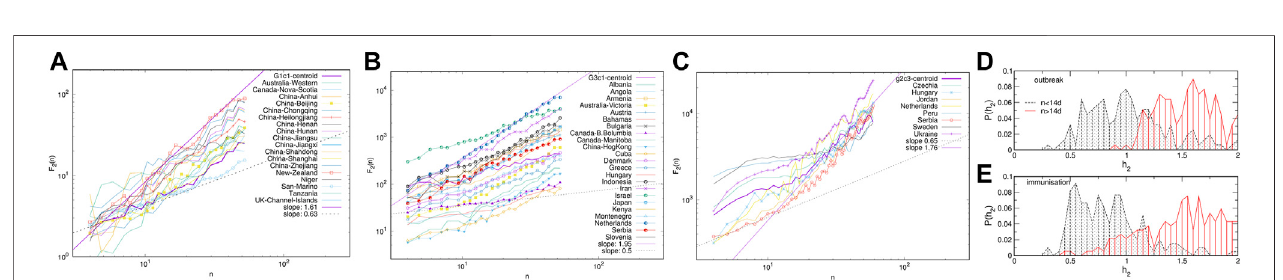
FIGURE 6 | Examples of the standard deviation F 2 ( n ) of time series vs . the interval length n for K-means clusters G1c1 and G3c1 identi fi ed within topological communities G1 and G3 in the outbreak (A,C) , and cluster g2c3 in the immunisation phase networks (C) . The distribution of the measured Hurst exponents for the intervals n < 14 days and n ≥ 14 days in the outbreak and immunisation phase (D,E) .